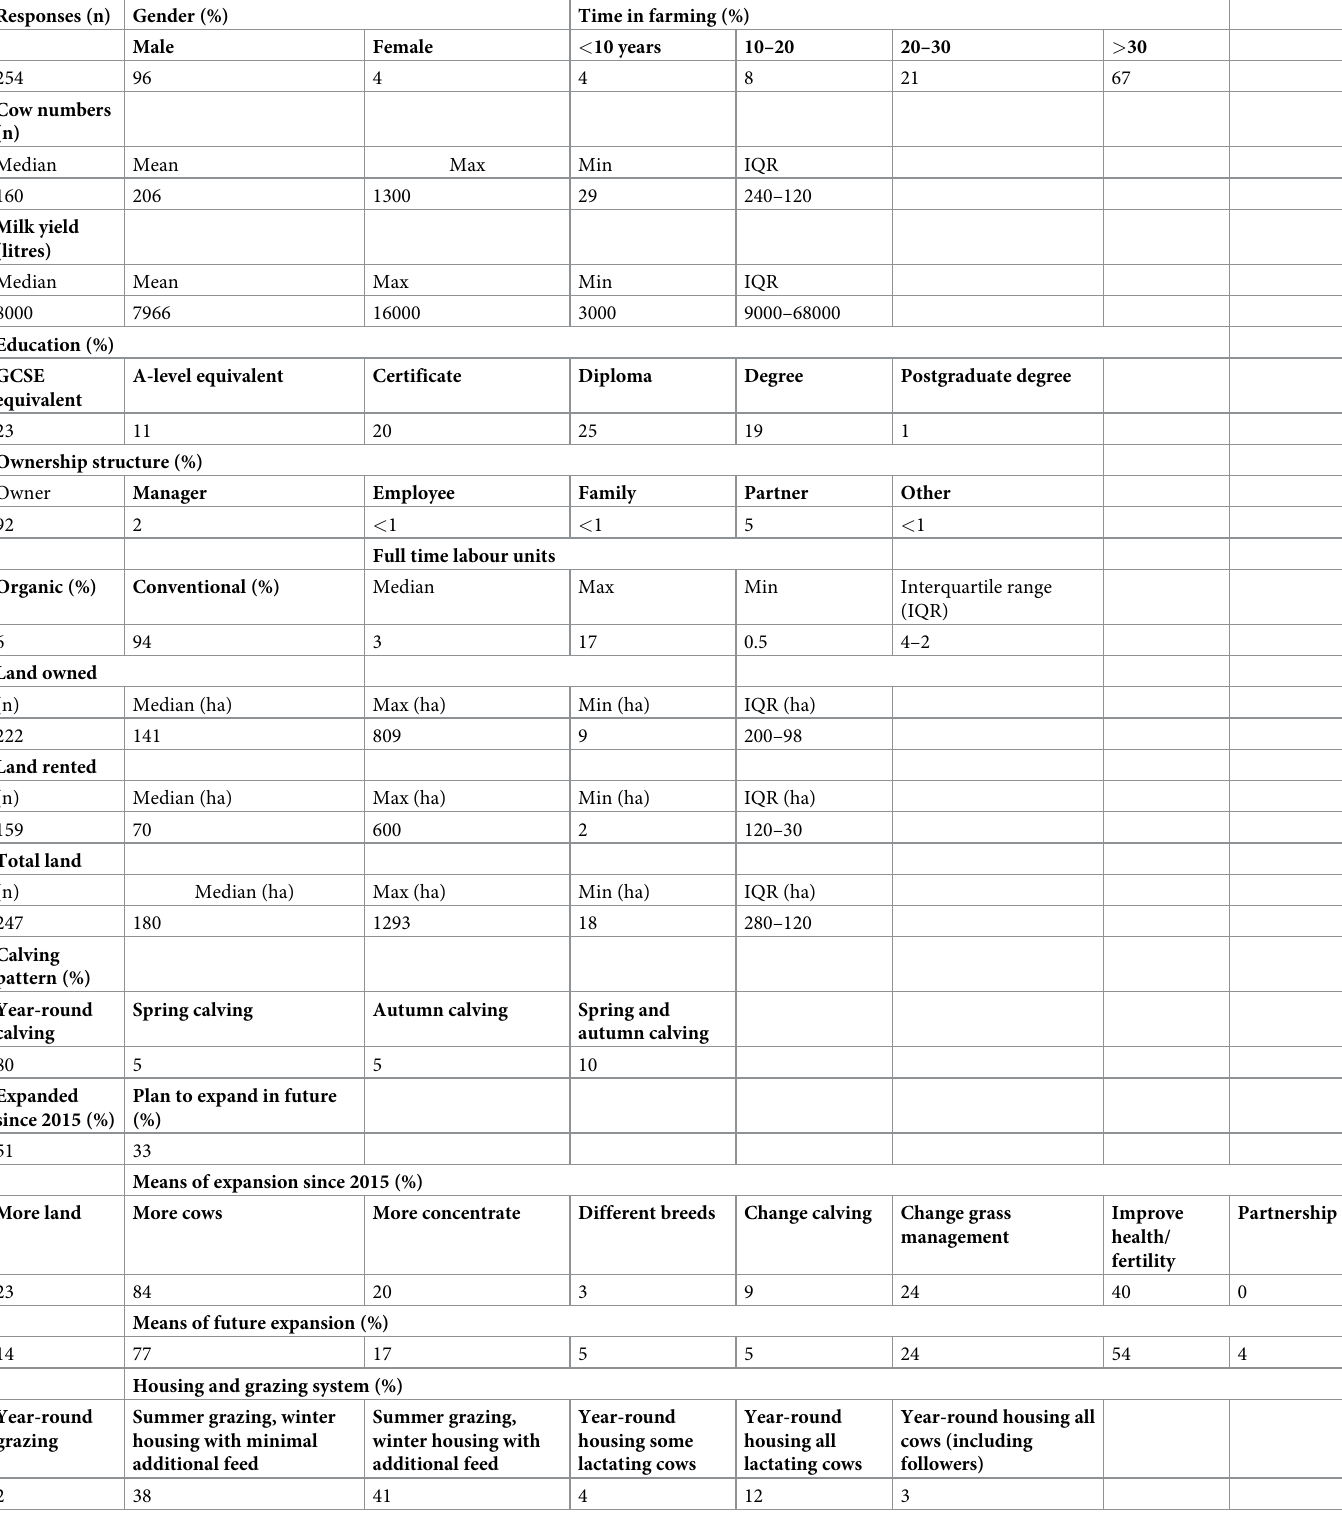
Table 1. Respondent descriptive